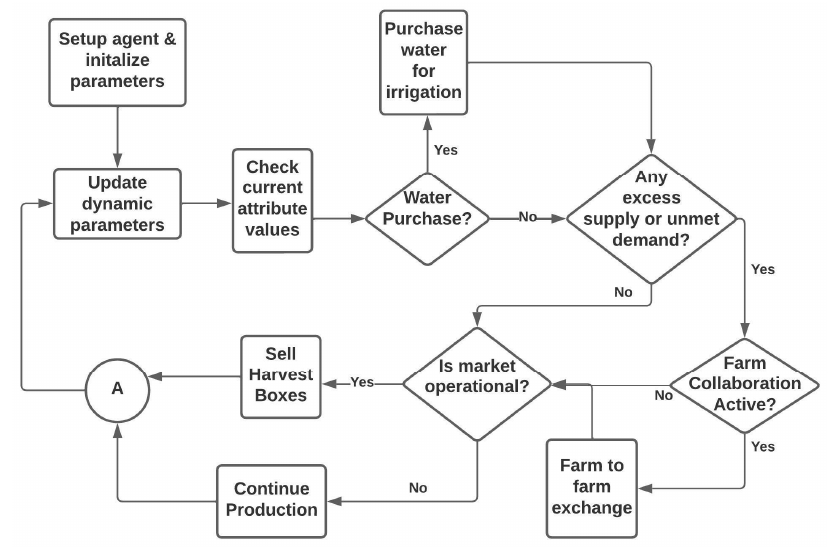
Figure 3. Farmer agent decision-making process.